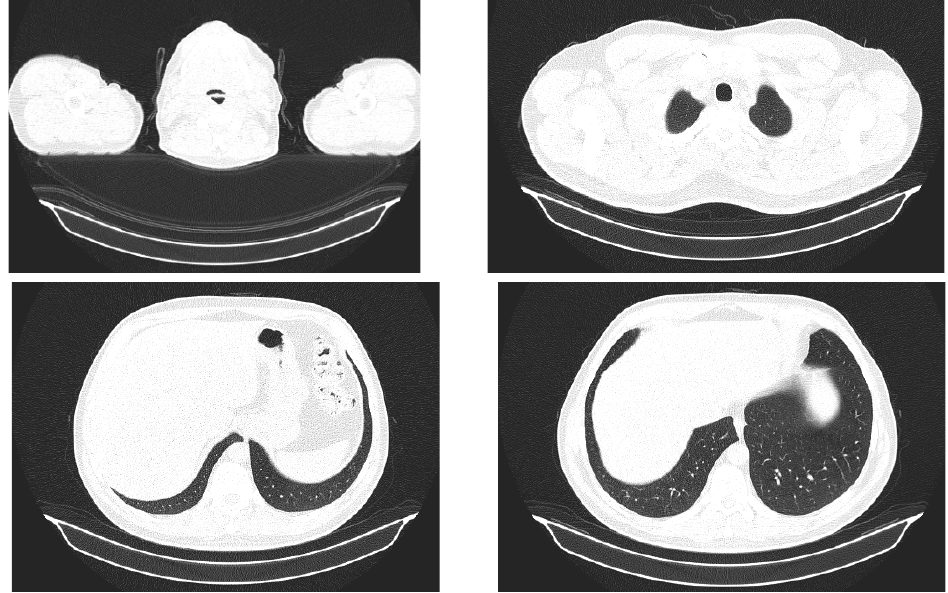
Figure 3. The diversity of the dataset.